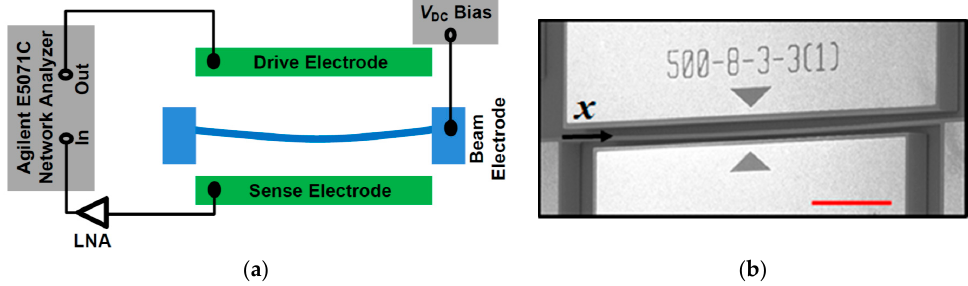
Figure 1. ( a ) Block diagram of the two-port electrical transmission measurement; ( b ) an scanning electron microscope (SEM) image of the arch beam resonator. The scale bar is 100 µm. LNA: low noise